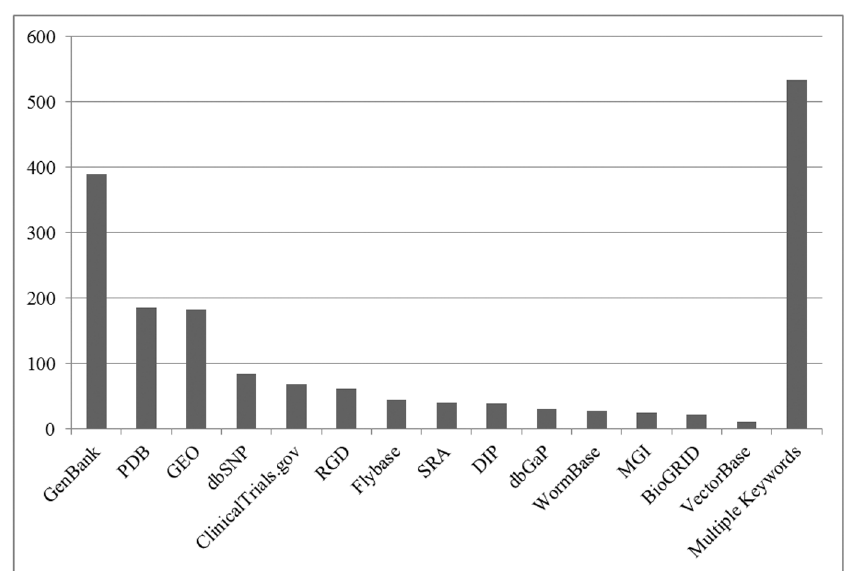
Fig 5. Keywords identified from full-text XML data